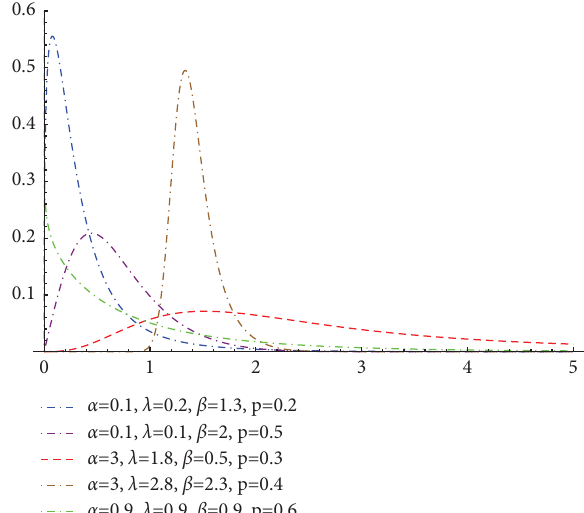
Figure 3: Te HRF of the PGEcr/GeTNH model for diferent parameters values.